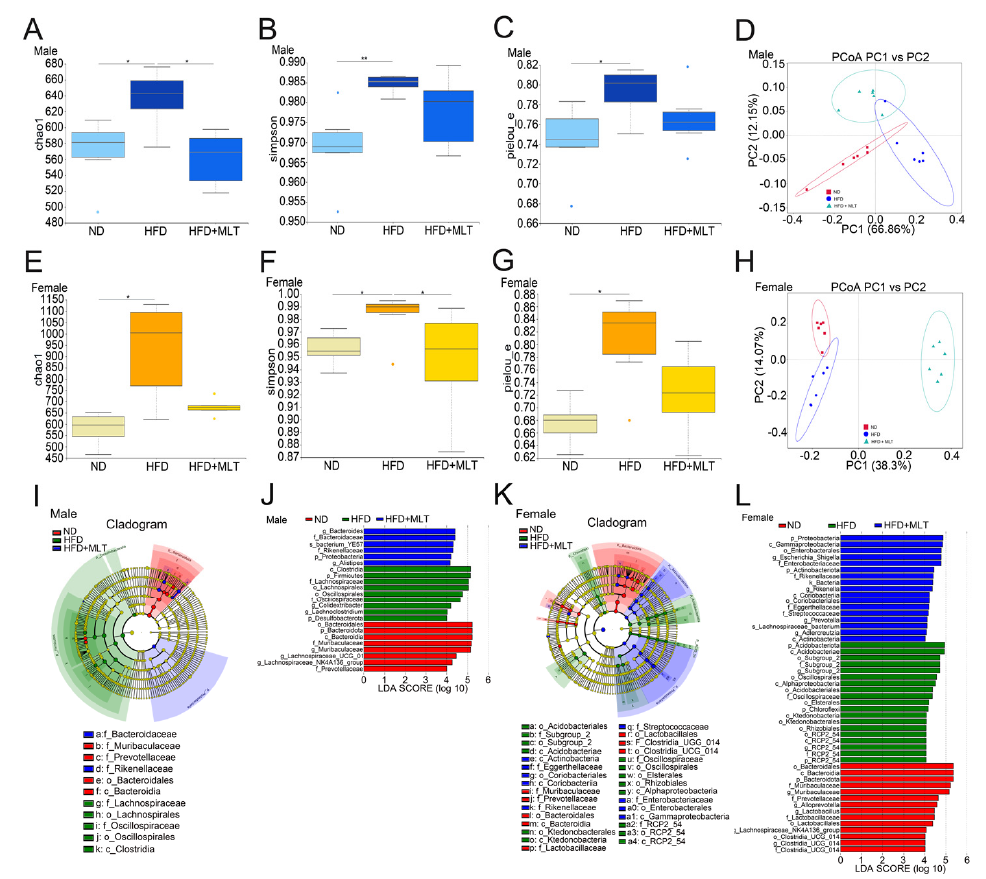
Figure 5. MLT treatment retains the intestinal bacterial flora composition pattern impaired by an HFD. After treating mice with an HFD and MLT for two weeks, feces were collected and evaluated by 16S rRNA high-throughput sequencing. The Chao1 diversity, Simpson, and Pielou’s evenness indices of enteric bacteria in male ( A – C ) and female ( E – G ) mice were measured. The Wilcoxon rank-sum test revealed statistical significance. PCoA was used to assess the gut microbiome taxonomic profile of male ( D ) and female ( H ) mice ( n = 6 mice per group). LEfSe results showed that bacterial abundance was significantly different between the HFD and ND groups of male ( I ) and female mice ( K ). The red, green, and blue regions represent enriched clades in the ND, HFD, and HFD + MLT groups. The yellow regions indicate species with no significant difference, and the size of the region indicates the amount of species abundance. Microbial taxa with significant differences between the three groups of male ( J ) and female ( L ) mice were counted using LDA analysis. The results are shown as the mean ± SEM, * p < 0.05, ** p < 0.01 between the two cohorts.(MLT, melatonin; HFD, high-fat diet; PCoA, principal coordinate analysis; LEfSe, linear discriminant analysis and effect size; ND, normal diet; LDA, linear discriminant analysis).